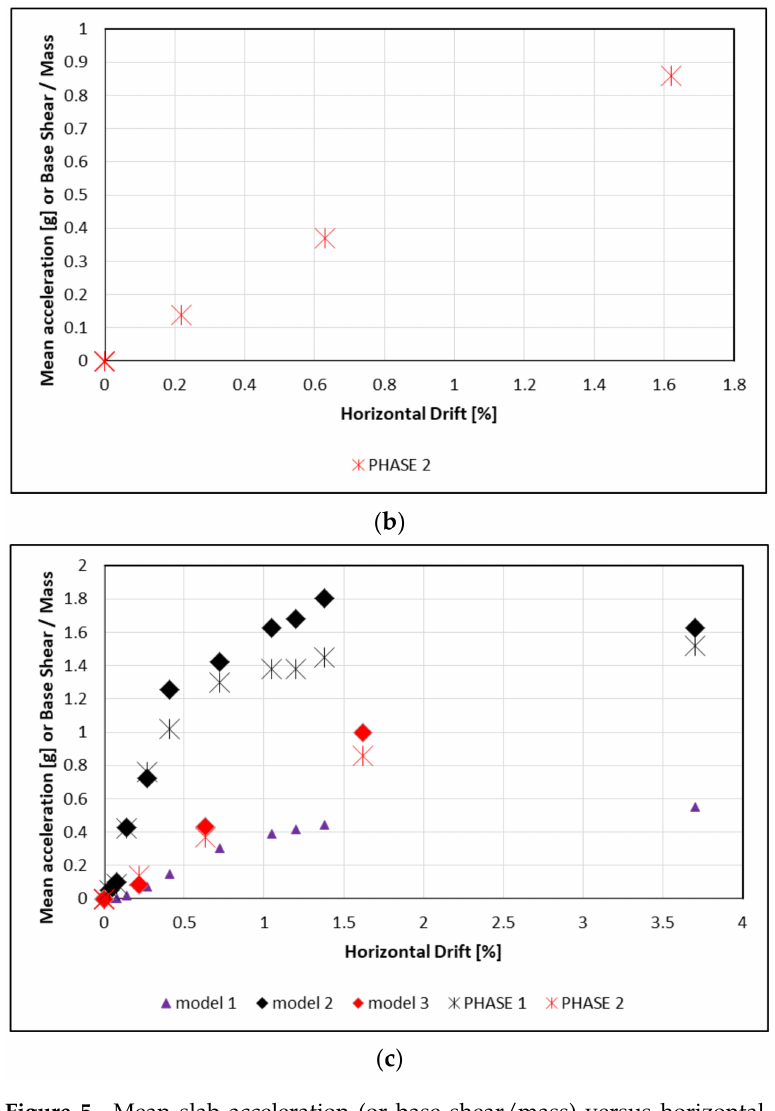
Figure 5. Mean slab acceleration (or base shear/mass) versus horizontal drift diagram ( a ) for experimental PHASE 1; ( b ) for experimental PHASE 3; and ( c ) for numerical model 1, model 2 and model 3, against the experimental results of PHASE 1 and PHASE